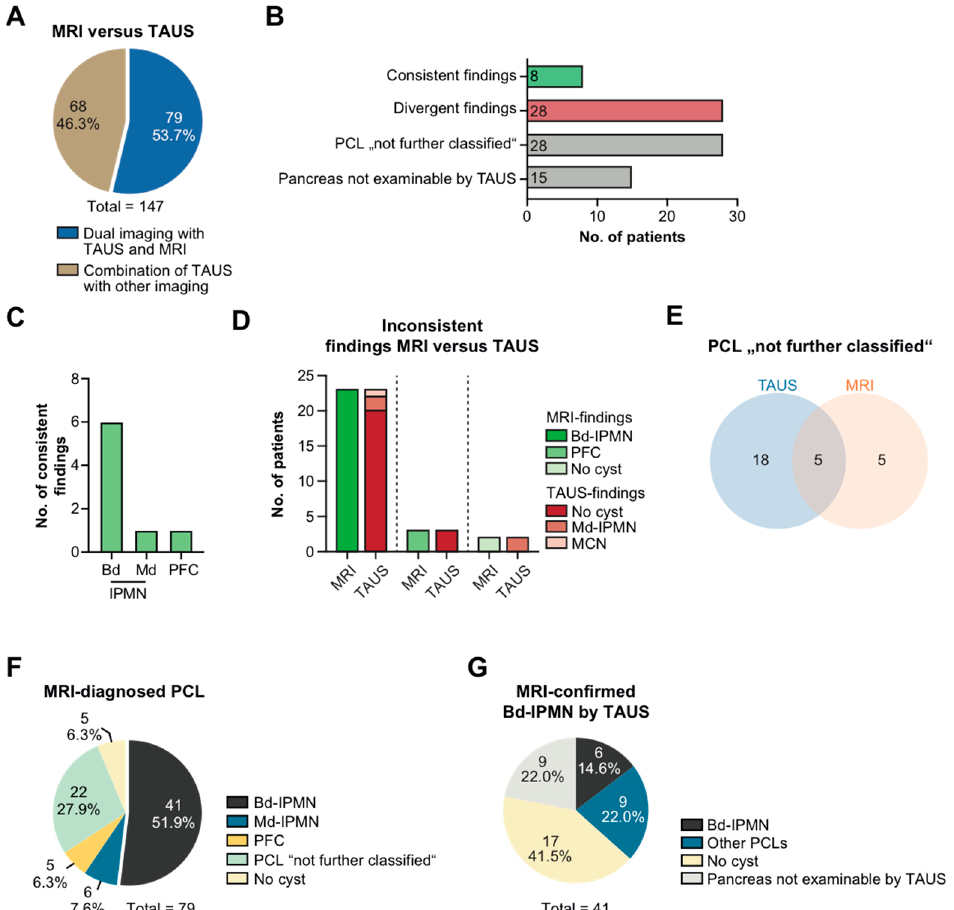
Figure 2. Diagnostic accordance between TAUS and MRI scans. ( A ) Patients with dual imaging combining TAUS with MRI or other type of imaging. ( B ) Patients (in absolute numbers) with MRI and TAUS assigned to the categories “consistent findings”, “divergent findings”, “PCL not further classified”, and “Pancreas not examinable by TAUS”. ( C ) Distribution of consistent findings. ( D ) Inconsistent findings between TAUS and MRI. ( E ) Venn diagram: non-classifiable PCL on TAUS and MRI. ( F ) Diagnostic categorization of PCLs evaluated by MRI (in absolute numbers). ( G ) Juxta- position of MRI-confirmed bd-IPMN with TAUS-based assessment (in absolute numbers). Trans- abdominal ultrasound, TAUS; magnetic resonance imaging, MRI; intraductal papillary mucinous neoplasm, IPMN; main duct type-IPMN, md-IPMN; branch duct type-IPMN, bd-IPMN; mucinous cystic neoplasm, MCN; post-pancreatitis fluid collection, PFC; pancreatic cystic lesion, PCL.